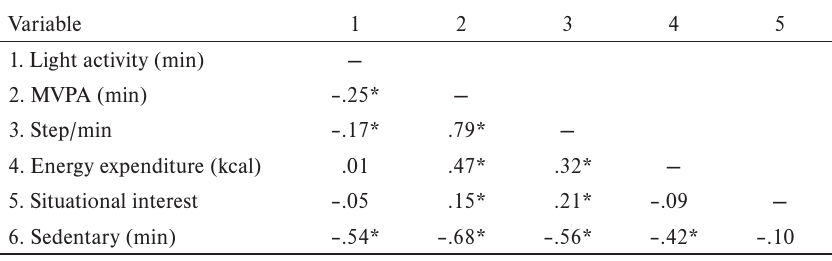
Pearson product-moment correlation coefficients between the variables